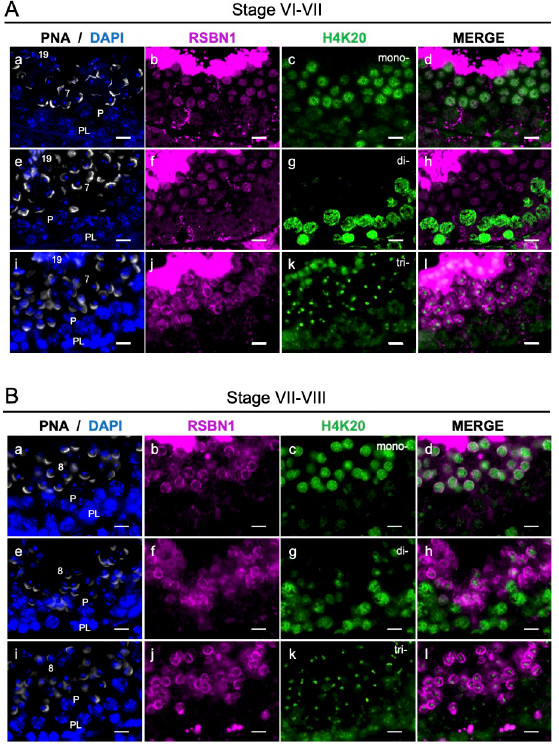
Fig 4. Distributions of methylated H4K20 and RSBN1 in the stage VIII of the seminiferous tubule. The distribution of nucleus and acrosome (DAPI, blue; PNA, white: a, e, i) and immunostained images of RSBN1 (magenta: b, f, j) and methylated H4K20 (green: c, g, k) in the stage VI-VII (A) and the stage VII-VIII (B) seminiferous tubules are shown. PL, pre-leptotene spermatocyte; P, pachytene spermatocyte; Numbers, steps of spermatids. Scale bars = 10 μ